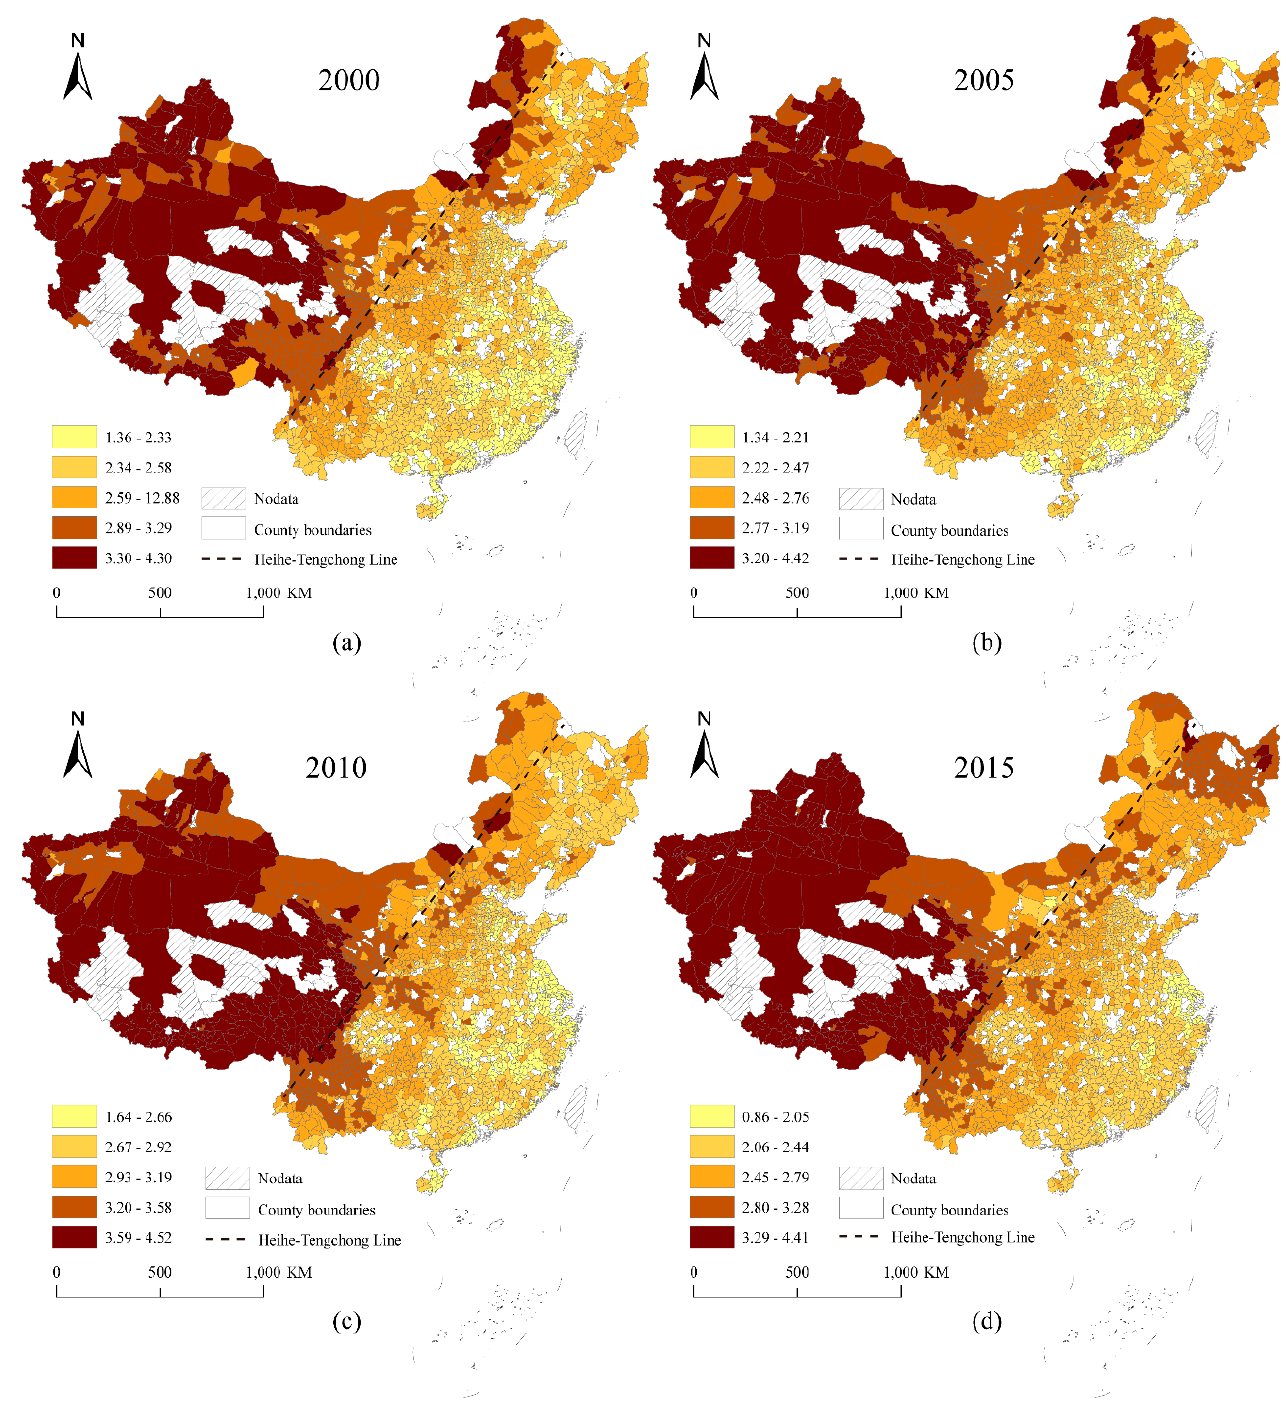
Figure 4. Spatiotemporal pattern of the CMPI at five-year intervals from 2000 to 2015 (from Fig.4(a) to Fig.4(d), respectively). A higher value means a higher degree of poverty in the county. The black dash line is the Heihe − Tenchong Line (also known as the Hu Line), whose east part is the high population density area in China, while the west part is the low population density area.